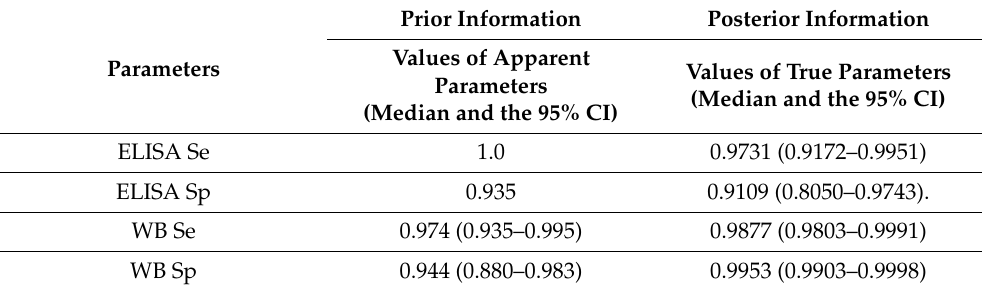
Table 1. The prior and posterior medians and lower and upper limits of the posterior equally tailed 95% credible intervals for the sensitivity (Se) and specificity (Sp) of ELISA and western blot (WB).